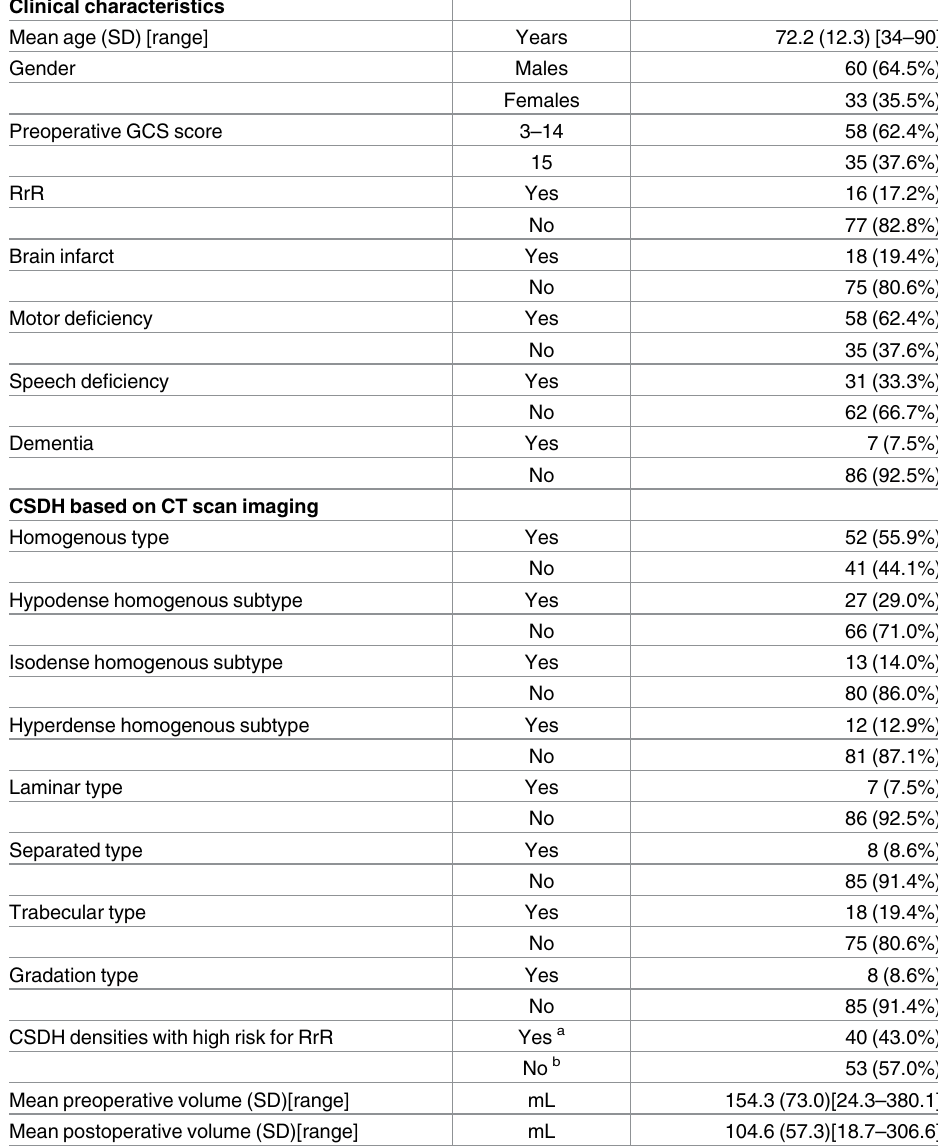
Table 1. Study population characteristics of CSDH patients (n = 93). Clinical